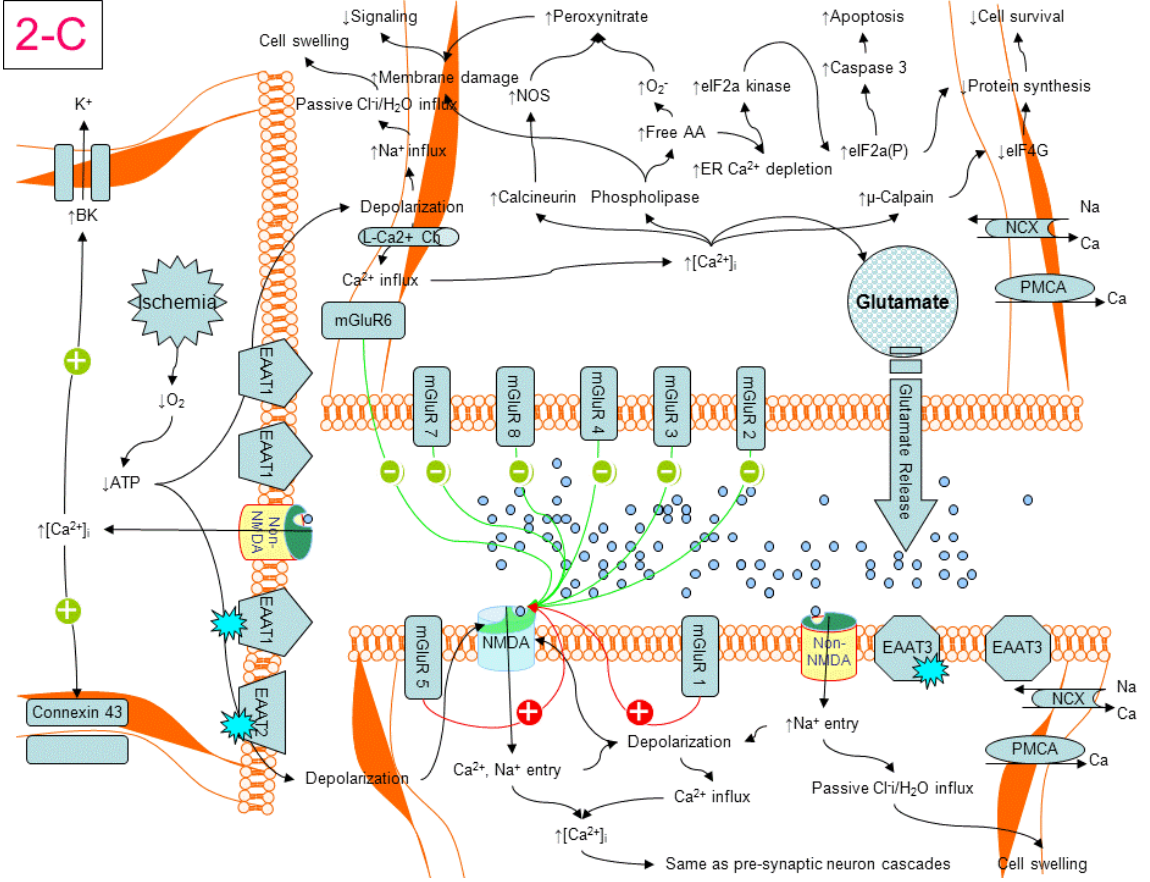
FIGURE 2-C. Injuries caused by ischemia occur in a wide range of subcellular regions of the synapse and astrocyte (green arrow: neuroprotective, red arrow: neurodegenerative). Abbreviations not listed for previous figures: BK, background K channel; eIF2a (P), phosphorylated eukaryotic initiation factor 2-a; eIF4G, eukaryotic initiation factor 4-G; ER, endoplasmic reticulum; L-Ca 2+ Ch, L-type Ca 2+ channel; mGluR, metabotropic glutamate receptor; PMCA, plasma membrane Ca 2+